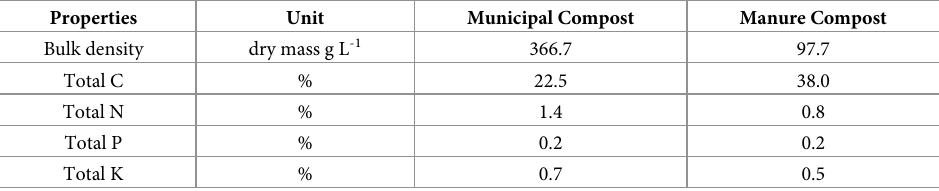
Table 1. Manure and municipal compost physical and chemical properties averaged for 2017 &